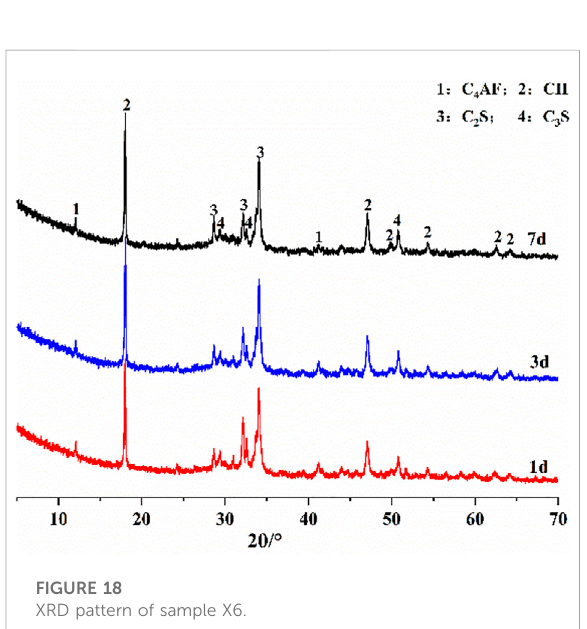
FIGURE 18 XRD pattern of sample X6.